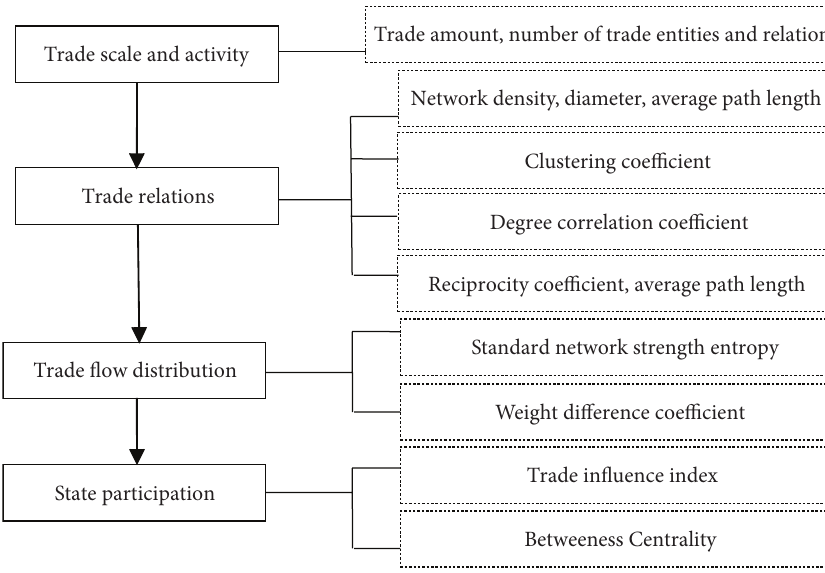
Figure 2. Complex network model logic